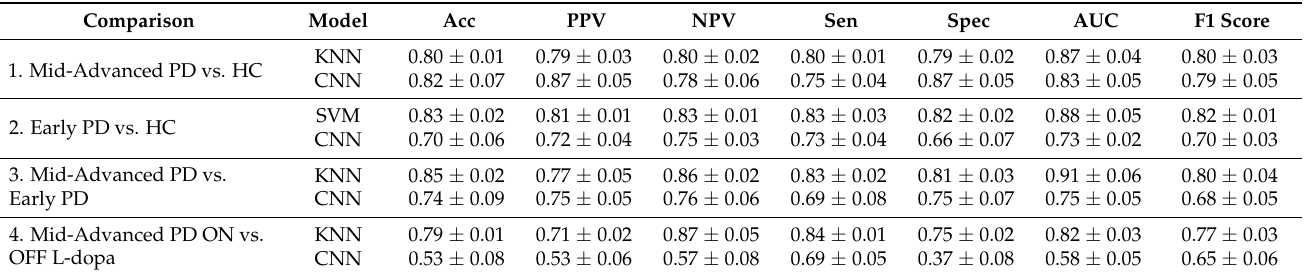
Table 6. Binary classification performance of the best traditional ML and CNN models. Results are reported in terms of CV accuracy. Acc: accuracy; PPV: positive predictive value; NPV: negative predictive value; Sen: sensitivity; Spec: specificity; AUC: area under the curve.